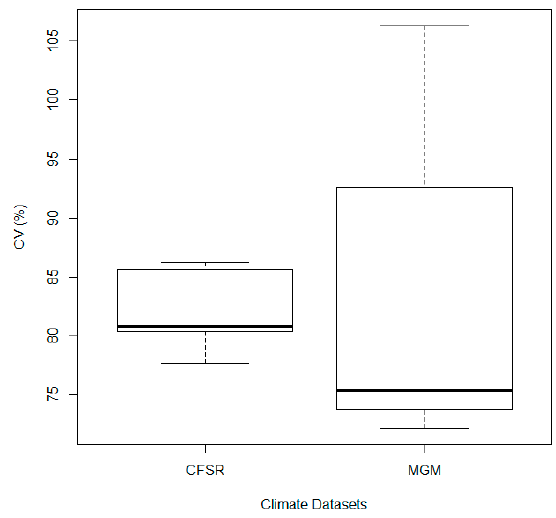
Figure 12. Comparison of the uncertainty in the water resource components stemming from the use of two different climate input. The boxplot shows the 25th and 75th percentiles of coefficient of variation (CV%) at all discharge gauges and the whiskers show the maximum and minimum.